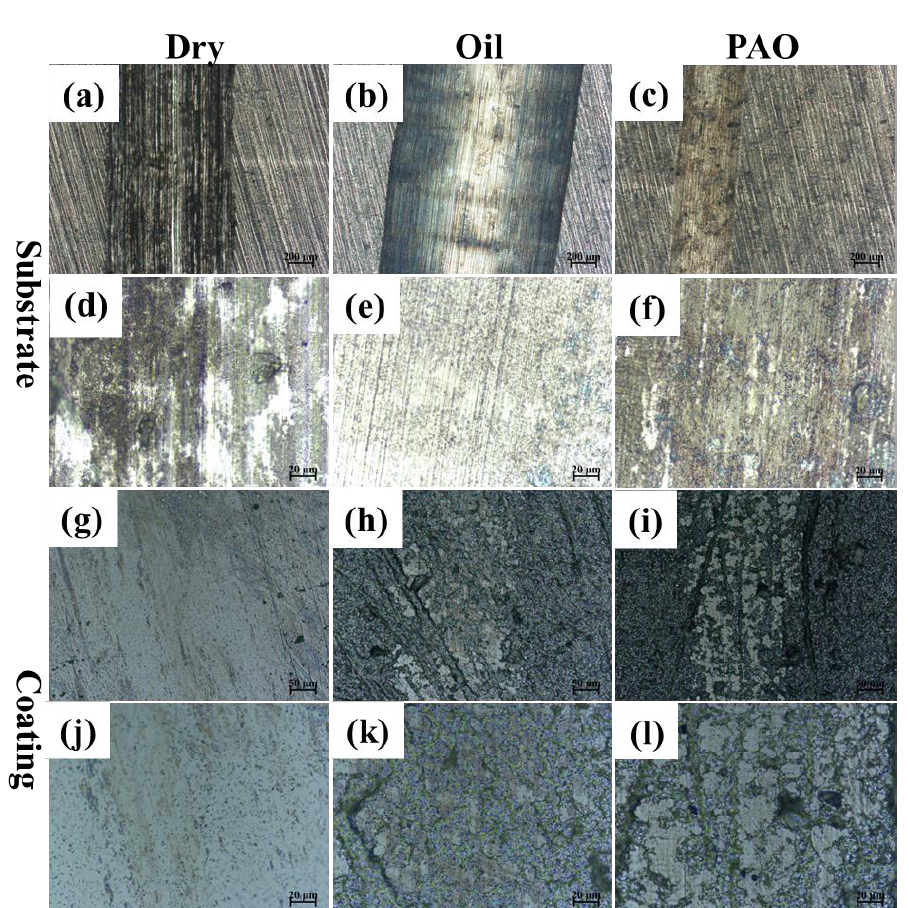
Figure 9. Optical observation of worn traces ( a – f ) over Al – Si substrates and ( g – l ) Ni – Co – P/Si 3 N 4 composite coated specimens under dry conditions and with lubrication with PAO and engine oil.